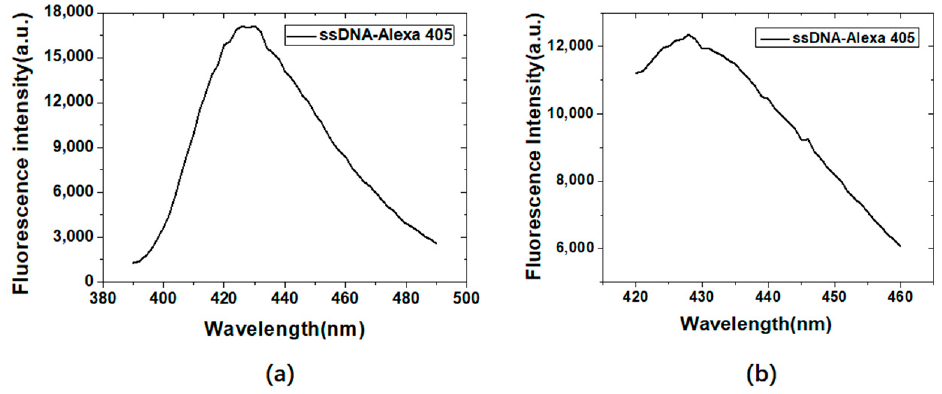
Figure 4. Fluorescence emission scanning results of Alexa405 labeled ssDNA at excitation wave- lengths of 300 nm ( a ) and 370 nm ( b ). Figure 5a,b are the fluorescence emission scanning results of ROX labeled ssDNA at excitation wavelengths of 500 nm and 550 nm, respectively. The maximum fluorescence emission wavelengths of the Alexa405 labeled ssDNA and the ROX labeled ssDNA were 428 nm and 614 nm, respectively, which did not depend on the excitation wavelength. The larger the excitation wavelength, the stronger the fluorescence intensity.